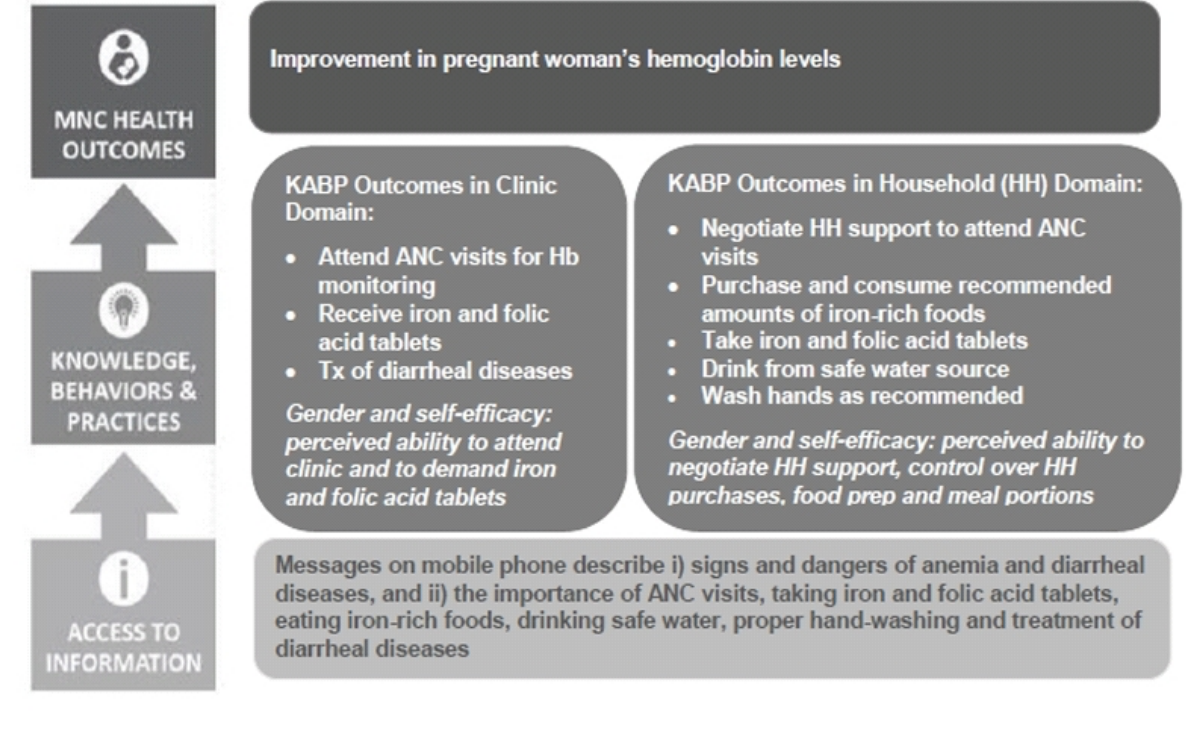
Figure 2. Pathway to change for hemoglobin levels in mMitra. ANC: antenatal care; Hb: hemoglobin; HH: household; KABP: knowledge, attitudes, behavior, and practices; MNC: maternal, newborn, and